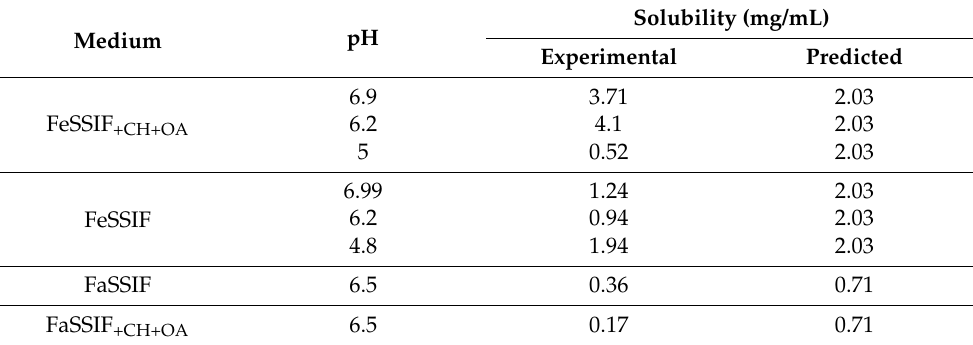
Table 6. Experimental vs. SIVA v4 predicted solubilities of GSK254 and different biorelevant